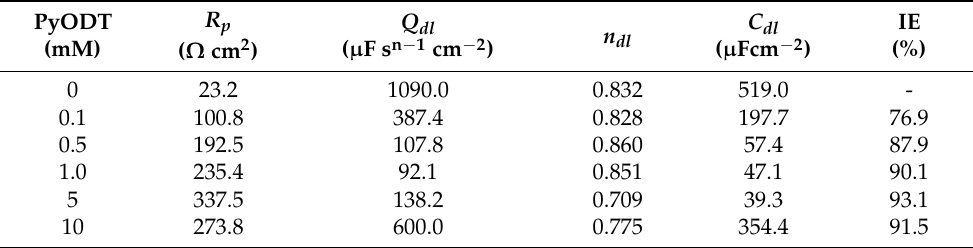
Table 2. Impedance parameters for C-carbon steel corrosion in the absence and the presence of PyODT at different